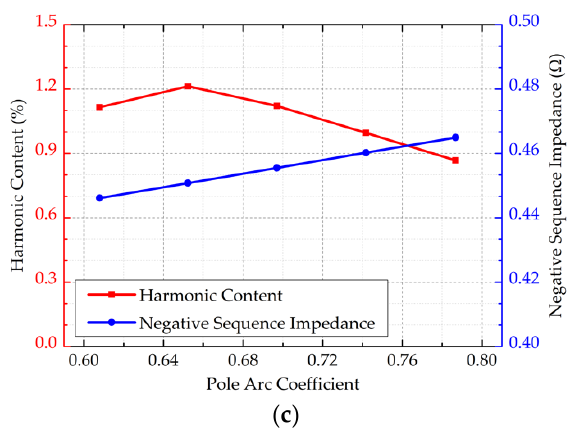
Figure 5. Harmonic content and negative sequence impedance variation curve with air gap size parameters: ( a ) Effect of armature slot opening; ( b ) Effect of air gap length; ( c ) Effect of polar arc coefficient.